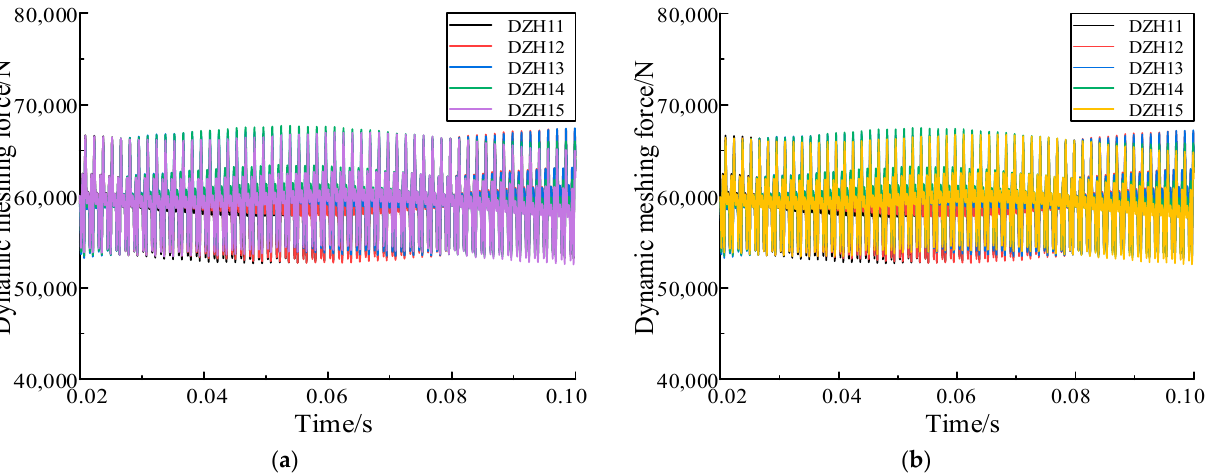
Figure 4. Dynamic meshing force with sun wheel error. ( a ) Lumped mass method and ( b ) rigid coupling model.